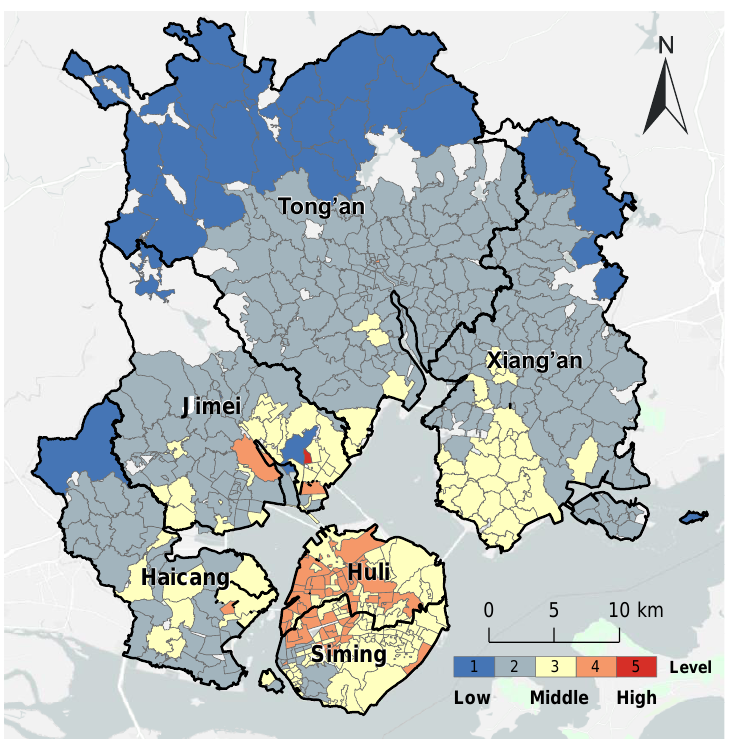
bility in Xiamen City.